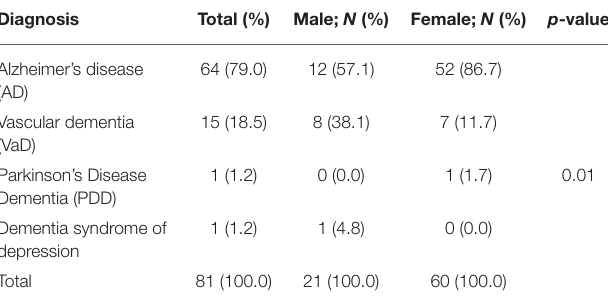
TABLE 2 | Diagnosis of dementia subtypes in the incident